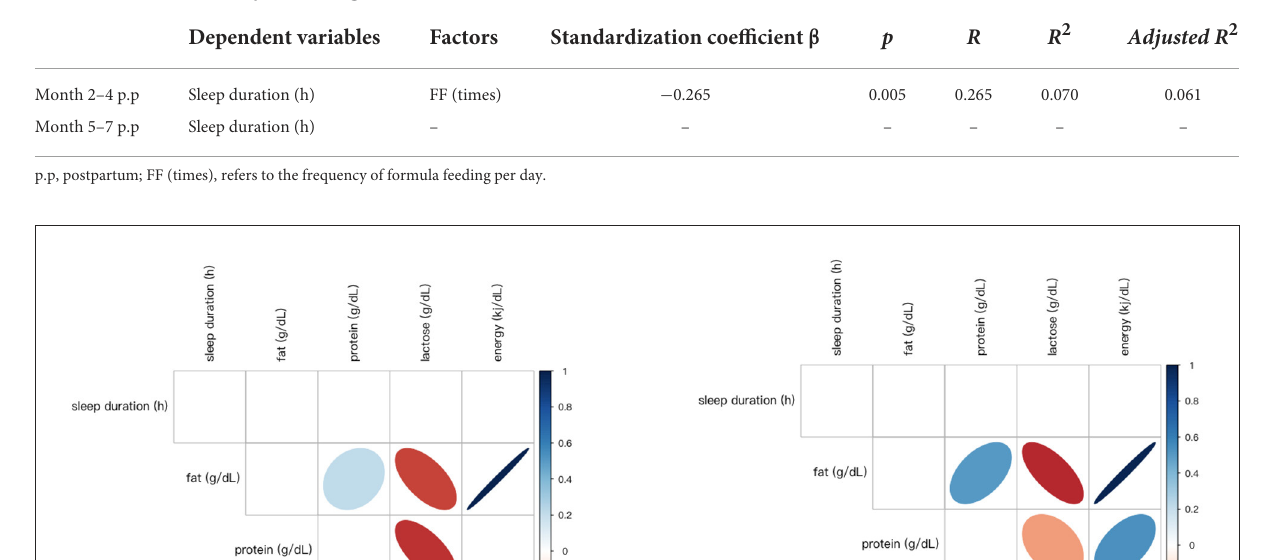
TABLE 2 Statistics of multiple linear regression.